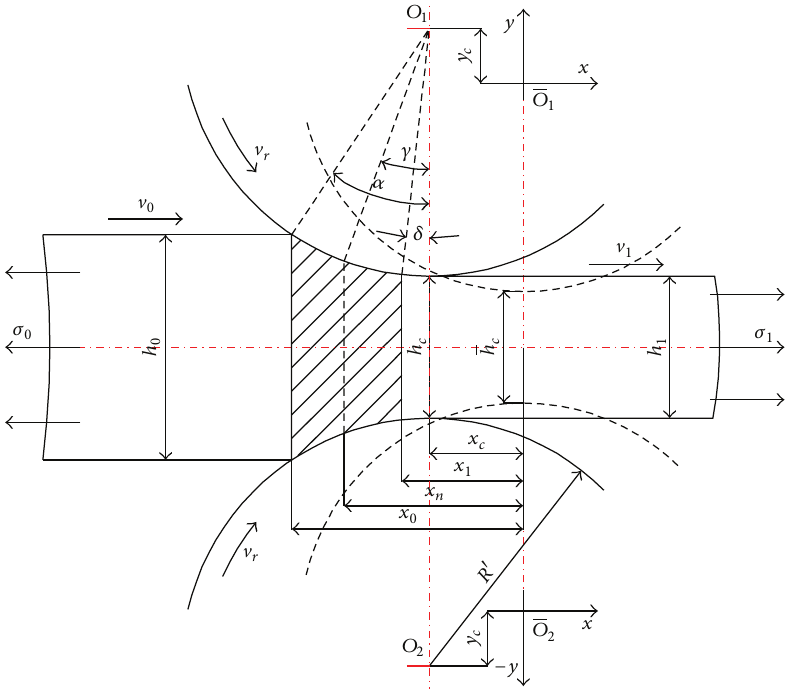
Figure 3: Roll bite geometry during